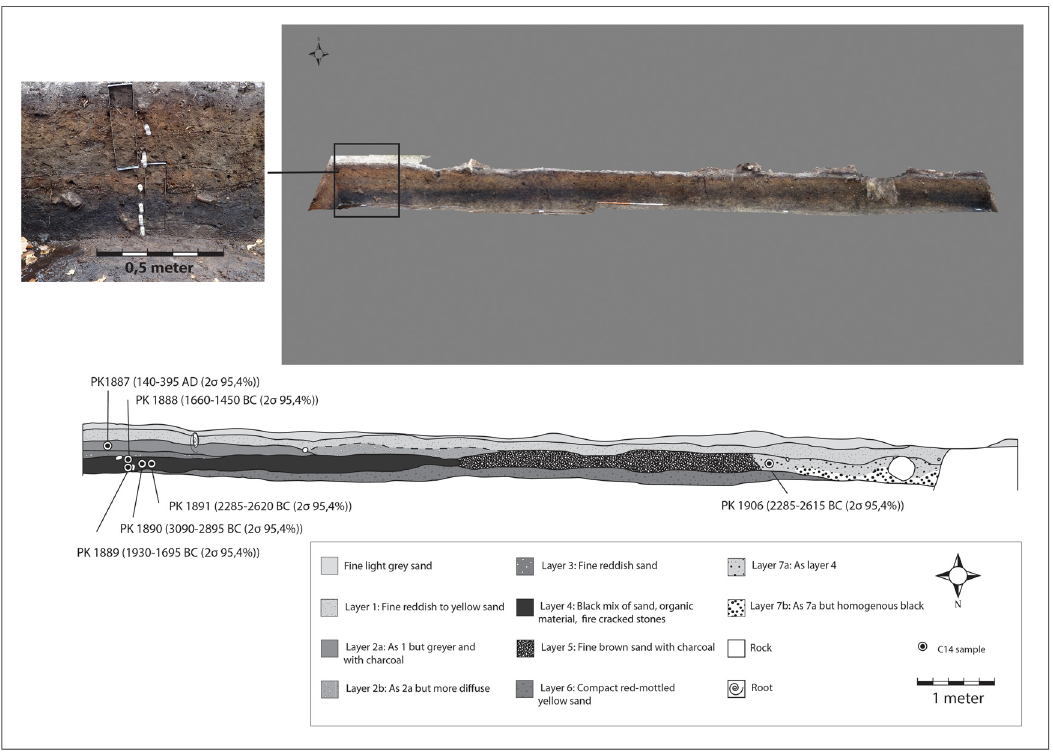
Figure 3: Stratigraphy of one of the sections, C1600, with C14 - samples marked. The box to the left show micromorphology and pollen outtakes during sampling. Layers 4, 7a and 7b represent layers deposited during the Middle Neolithic, partly disturbed by bioturbation. Layers 1, 2a - b, and 3 are colluvial layers, indicating slope erosion, presumably due to removal of vegetation cover. Charcoal from layer 2a was dated to the Roman Iron Age ( illustration and photos: A. Mansrud/J. S. F. Stokke/M.